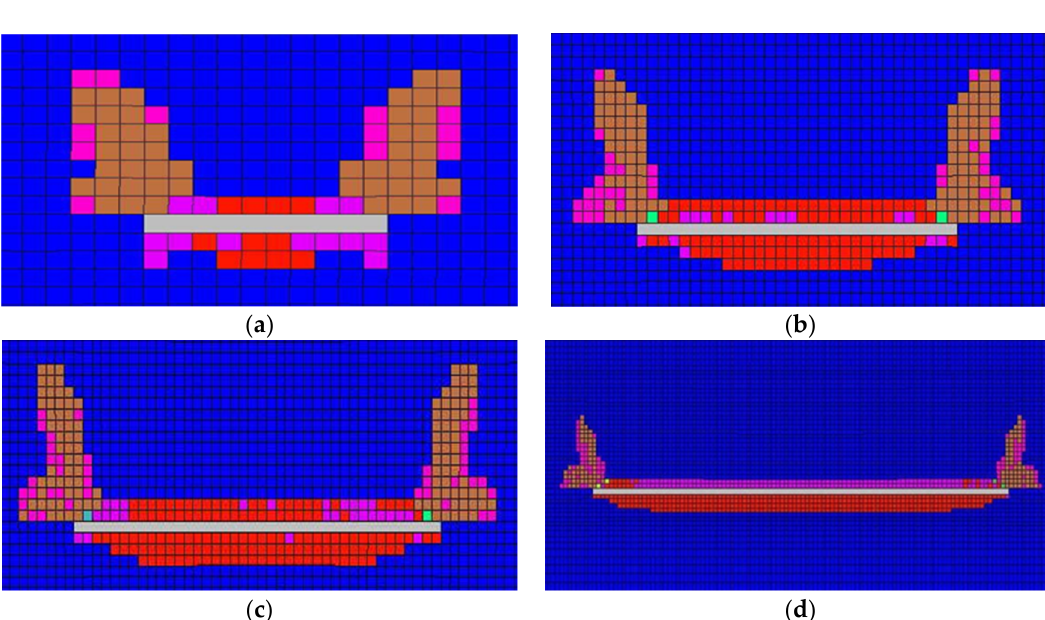
Figure 7. Development process of fracture zone in the roof and floor of coal seam during mining. ( a ) Mining distance of 50 m; ( b ) mining distance of 150 m; ( c ) mining distance of 200 m; ( d ) mining distance of 500 m.